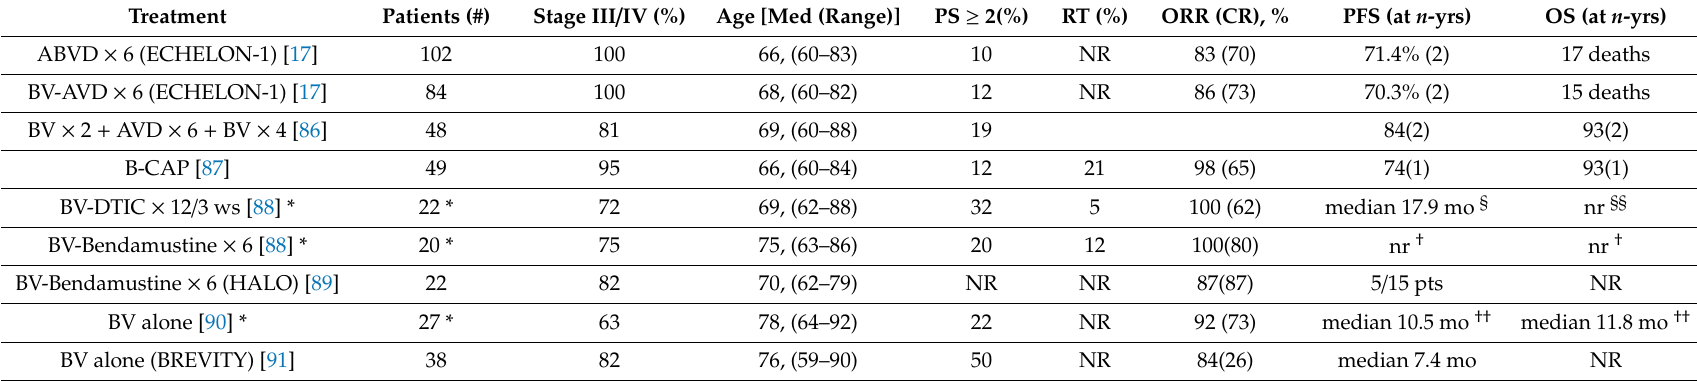
Table 5. Brentuximab vedotin combinations or monotherapy as first-line therapy in patients with advanced or predominantly advanced stage Hodgkin lymphoma (both approved and non-approved